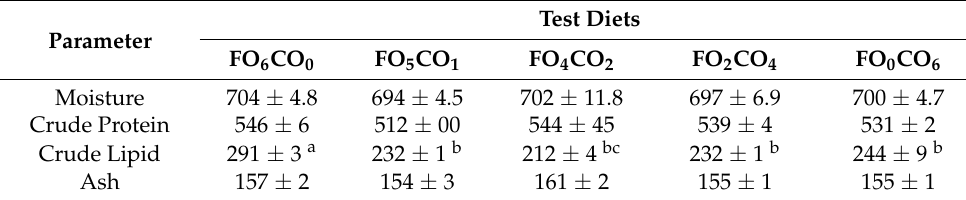
Values are expressed as the mean ± standard error (n = 3). Absence of superscript letters refers to non-significant differences between treatments ( p > 0.05) and presence of different superscript letters refers to significant differ- ences between treatments ( p <